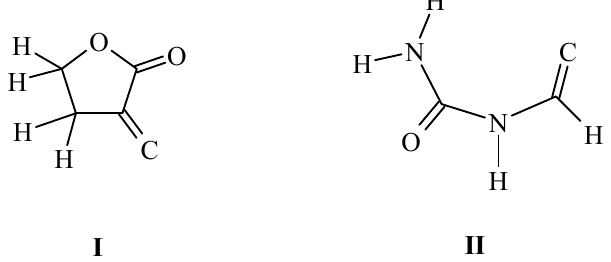
Figure 2 . Fragments from a Cambridge Structural Database survey.